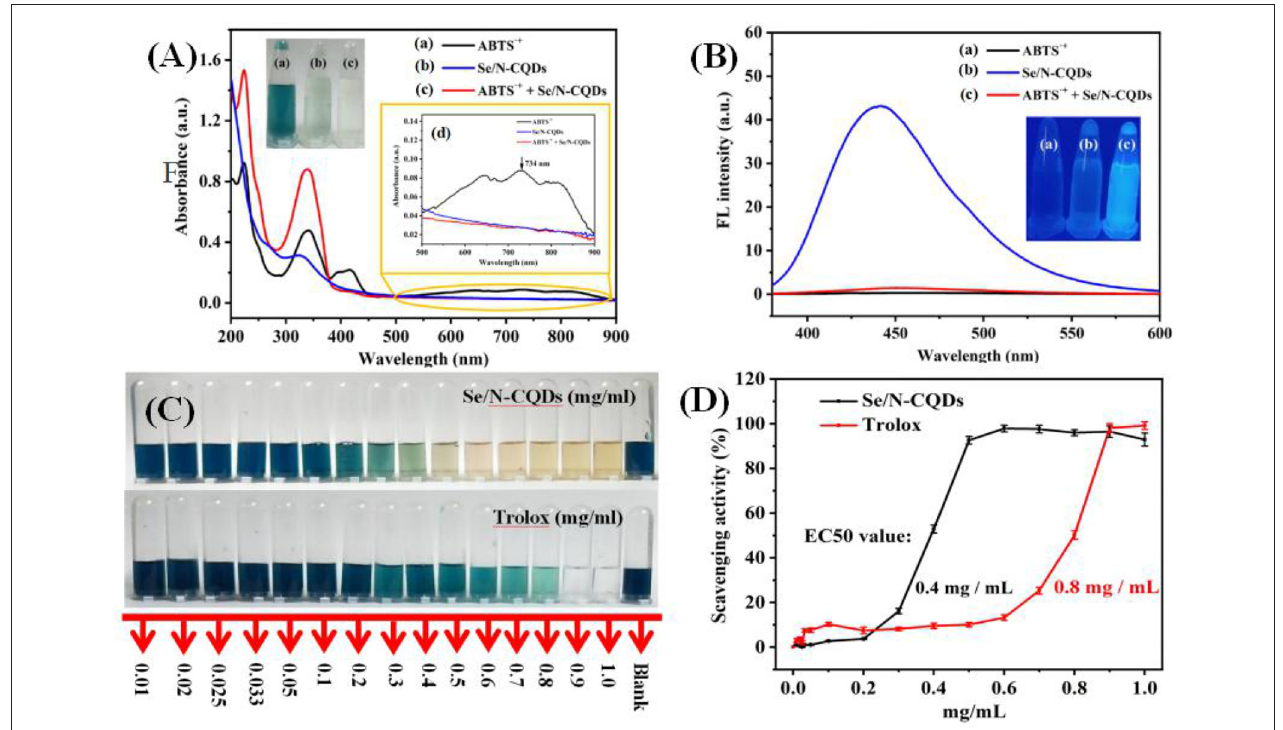
Figure 2 | (A) UV-Vis absorption spectra of ABTS •+ , Se/N-CQDs and ABTS •+ + Se/N-CQDs. Inserts: The photographs of ABTS •+ (a), Se/N-CQDs (b), and ABTS •+ + Se/N-CQDs (c) solutions under the white light irradiation, and (d) partial enlargement of UV-vis absorption spectra. (B) Emission spectra of ABTS •+ , Se/N-CQDs, and ABTS •+ + Se/N-CQDs. Inserts: the photographs of ABTS •+ (a), Se/N-CQDs (b), and ABTS •+ + Se/N-CQDs (c) solutions under the UV (365nm) light irradiation. (C) Photographic representations of bleaching of ABTS •+ solutions with a progressive increase in the concentration of Se/N-CQDs and Trolox, respectively. (D) ABTS •+ free radical scavenging activities of Se/N-CQDs and Trolox,